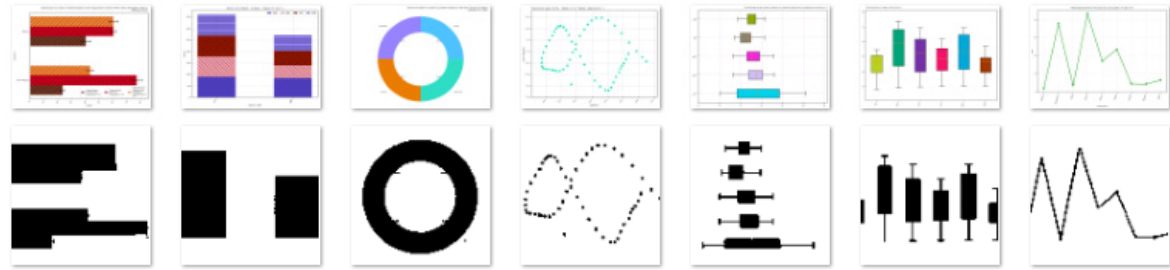
Figure 3. A sample from dataset 2 (198,010 images), from left to right: horizontal bar (22,304)—includes grouped and stacked, vertical bar (21,961)—includes grouped and stacked, pie (28,203)—includes pie and donut, scatter (41,703), horizontal box (21,007), vertical box (20,958), and line (41,874). In the top row are original images, and in the bottom, images after pre-processing.